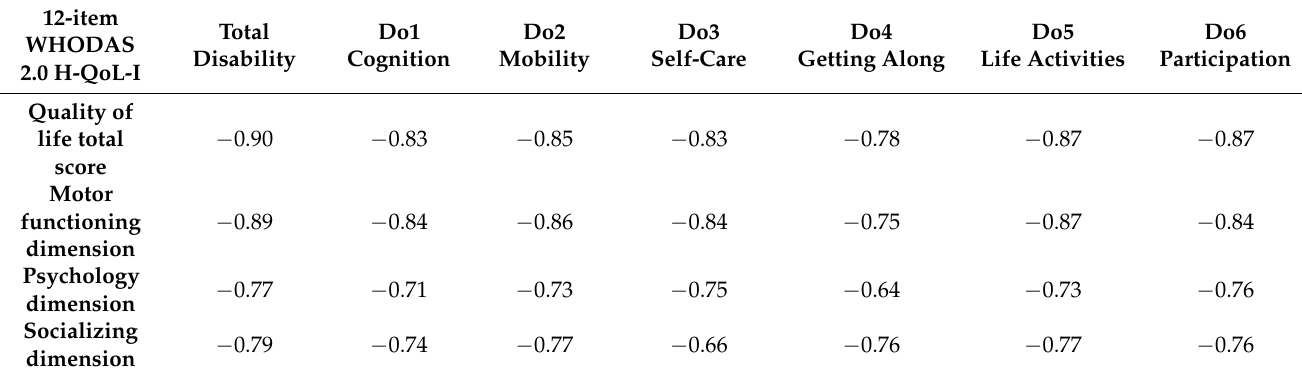
Table 3. The correlation of the 12-item WHODAS 2.0 and the H-QoL-I domains.